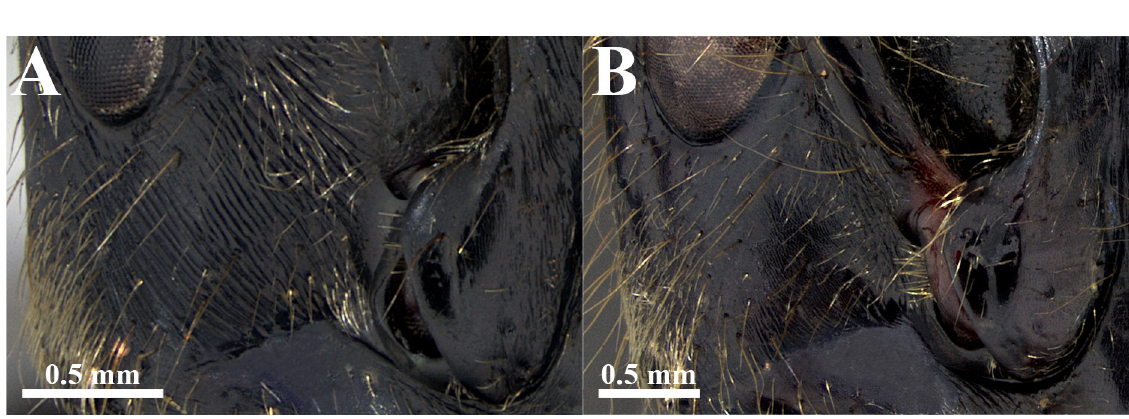
Fig. 8. Detail of malar area striae. A . Dinoponera grandis (Guérin-Menéville, 1838). B . D . gigantea